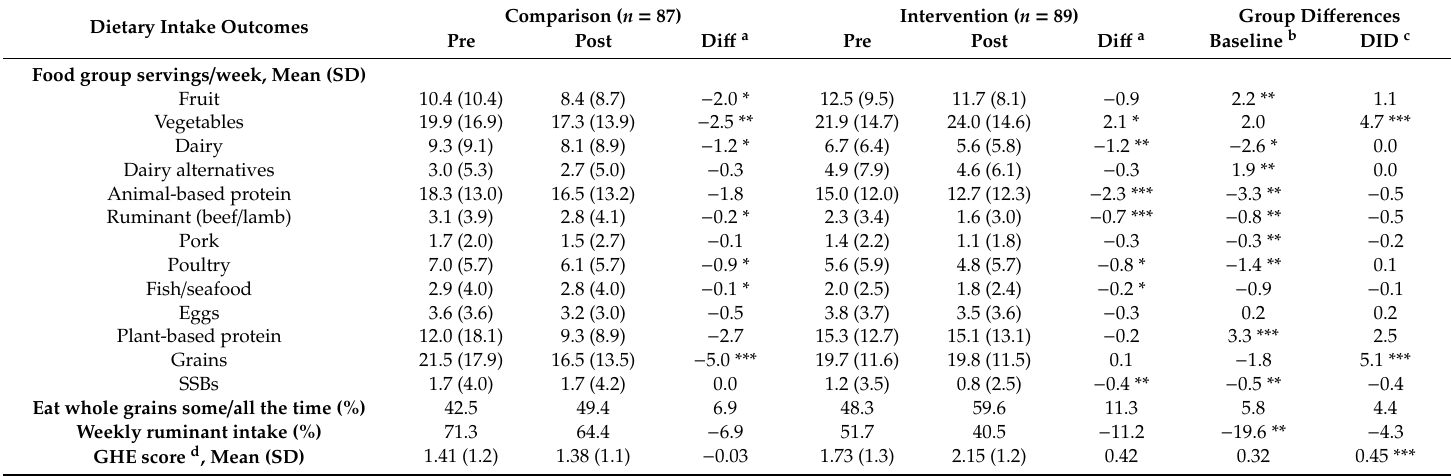
Table 3. Dietary intake outcomes by group and di ff erences between groups ( n =